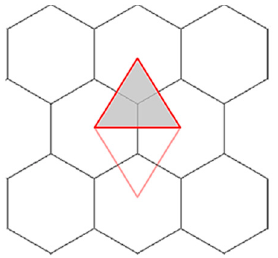
Figure 3. A single cell (Y element), as contained within a honeycomb structure.